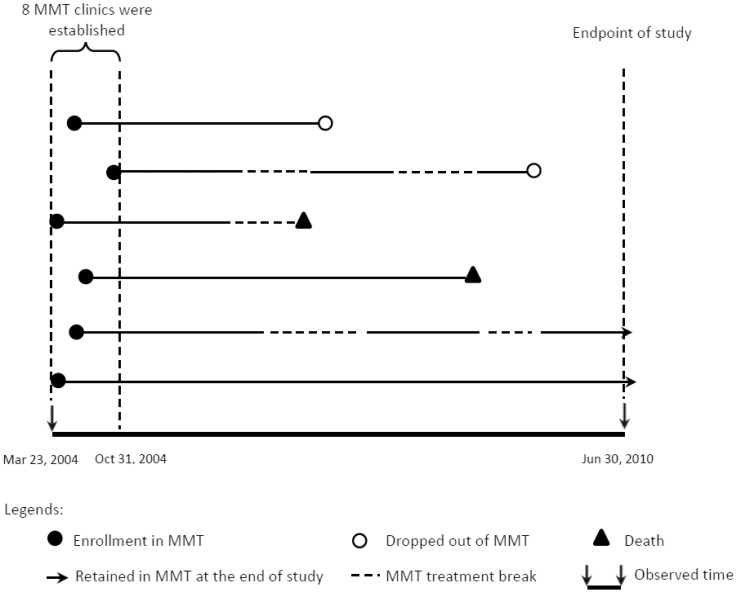
The overall picture of clients' treatment dynamics.The study participants were enrolled between March 23, 2004 and October 31, 2004, and followed until June 30, 2010. Treatment break means clients missed more than 30 consecutive days during the follow-up period. The first line (solid line) means a client was treated continuously before he/she dropped out of MMT. The second line means a clients dropped out of MMT for a period of time (broken line), reenrolled in MMT (solid line), and then dropped out of MMT again. Even if a client dropped out of MMT, he/she was followed so he/her (live or dead) was assessed during the follow-up period.